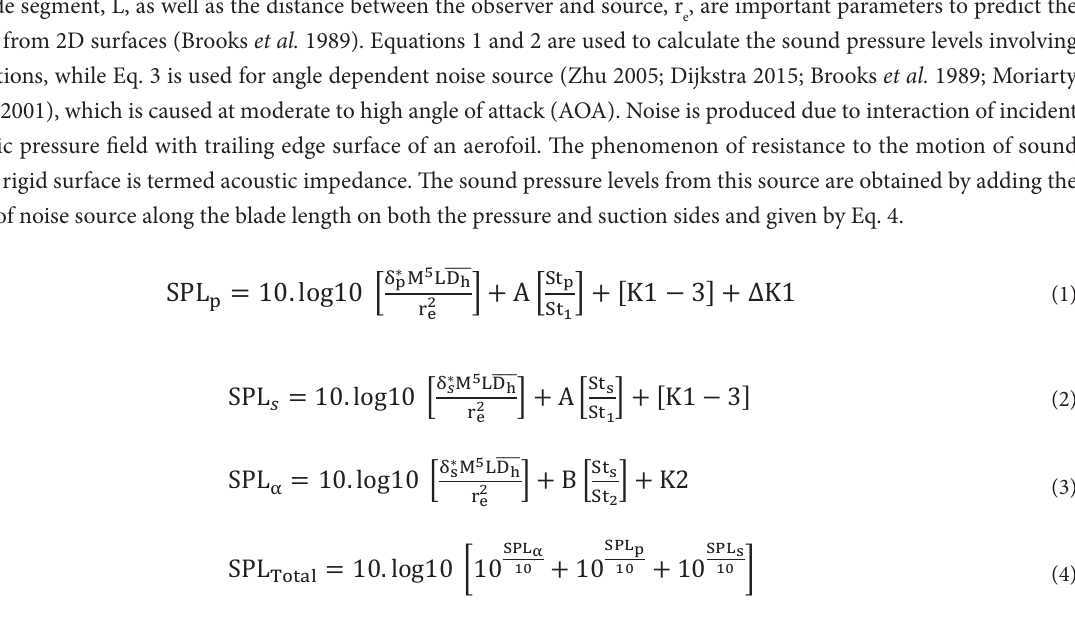
Figure 1. Schematic of major noise mechanisms from wind turbine blade. Adapted from Doolan et al. (2012); Grosveld (1985).